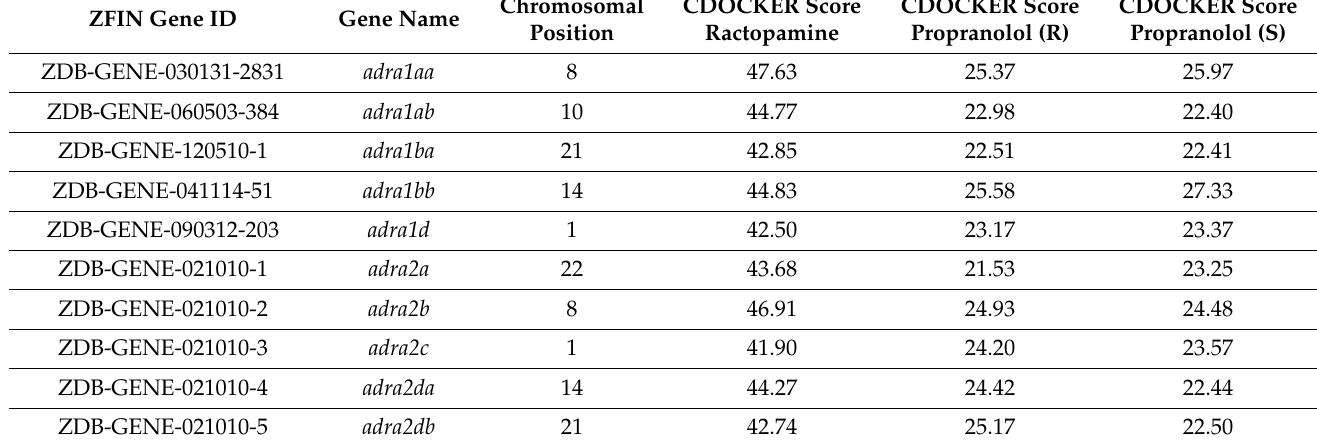
Table 1. Flexible molecular docking score for each homology modeling structure of endogenous β -adrenergic receptor subtype. The zebrafish subtype, adra1aa, binding to RAC, gains the highest CDOCKER scores, 47.63, while the human adra2a (6kux) gains 44.15. The zebrafish subtype, adra1aa, binding to PROP with a chiral center, gains the highest CDOCKER scores for S form, 27.33, while the human adra2a (6kux) gains 21.83 and 20.62, in R form and S form, respectively. PROP overall has lower binding affinity than